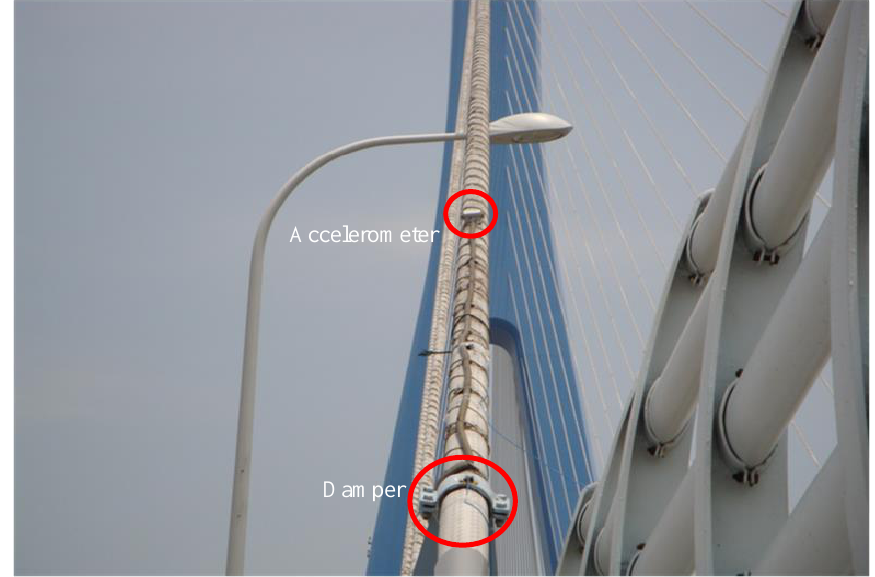
Figure 2. Deploy of accelerometers at a cable. The anemometers are installed 6.0 m vertically above the deck’s surface.